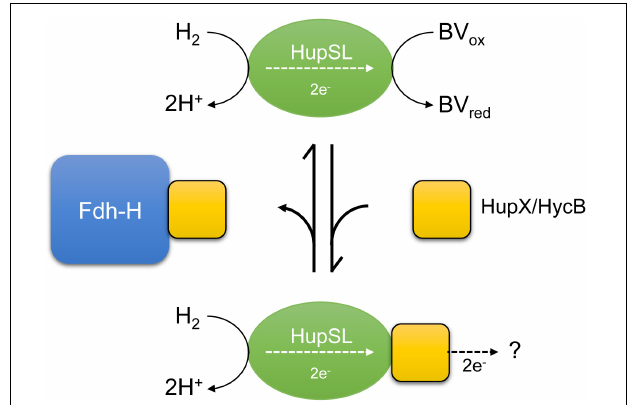
FIGURE 7 | A schematic depiction of the current interpretation of our data is shown. The hypothesis states that the HupSL heterodimer is capable of interacting with and reducing BV and if HupX or HycB are free and not sequestered by Fdh-H they prevent HupSL transferring electrons to BV and instead deliver them to currently unknown acceptor complexes, or possibly to the quinone pool (?). HupX has been shown to interact with HupSL (Hartwig et al., 2017; Seidel et al., 2018), while this has not been so far shown for